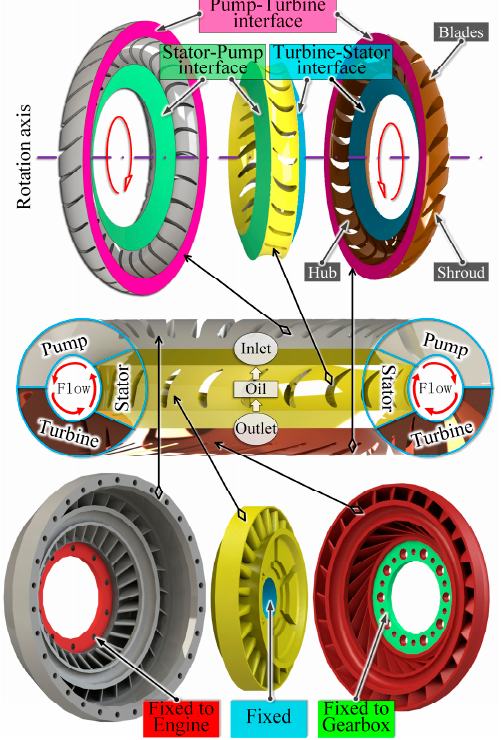
Figure 2. Full 3D flow model of the torque converter.